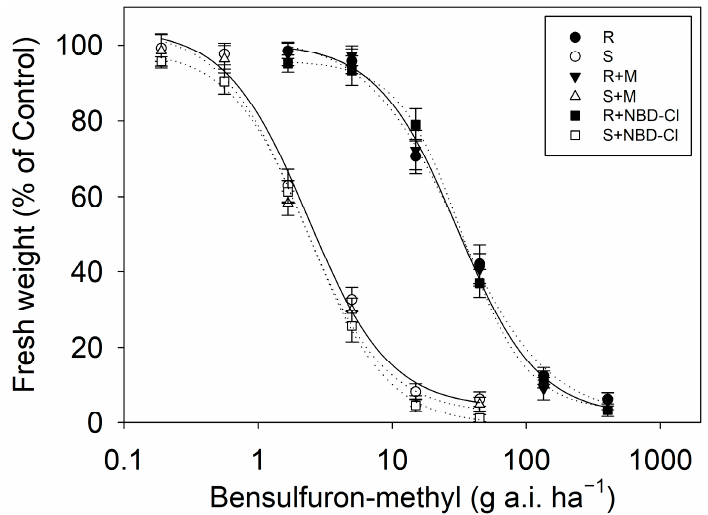
Figure 5. Dose–response curves for the fresh weights of S (HFLJ1, ○ ) and R (BBHY1, ● ) populations of C. di ff ormis treated with a range of bensulfuron-methyl doses plus or minus 1000 g a.i. ha − 1 malathion (M) ( ▼ , △ ) or 270 g a.i. ha − 1 4-chloro-7-nitrobenzoxadiazole (NBD-Cl) ( ■ , □ ). Vertical bars represent the standard errors of the means (SEMs).